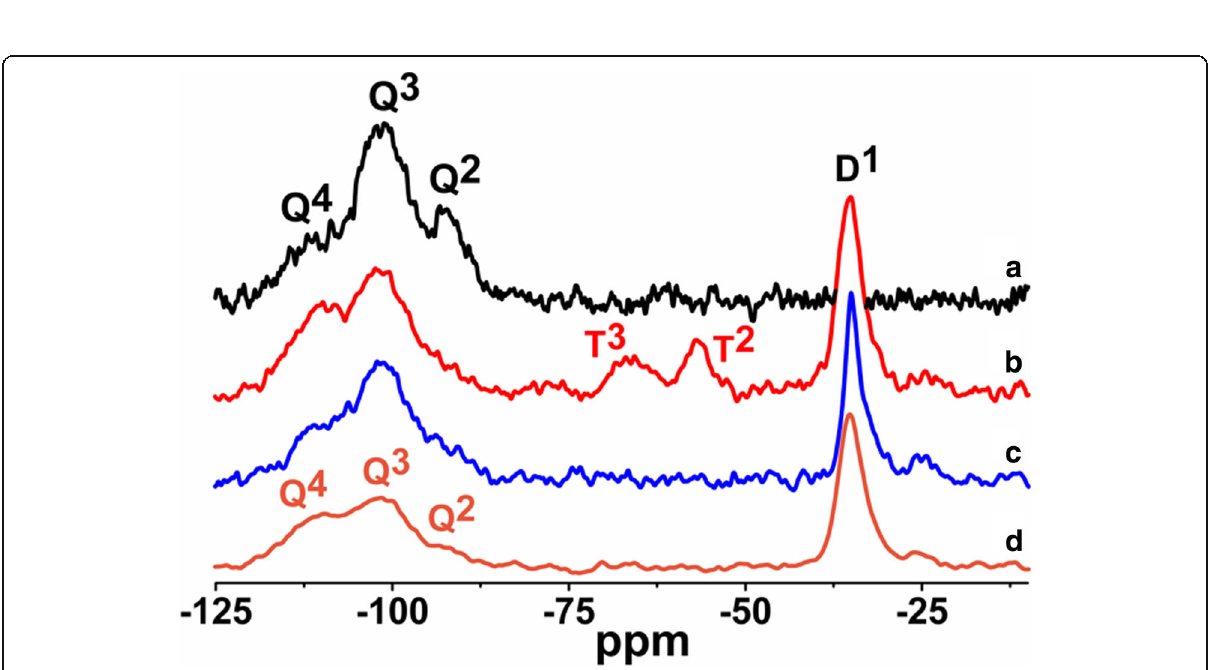
Fig. 3 29 Si CP/MAS NMR spectra of ( a ) neat fumed silica, ( b ) modified fumed silica with neat PMHS, modified with ( c ) mixtures of PMHS and dimethyl carbonate and ( d ) mixtures of PMHS and diethyl